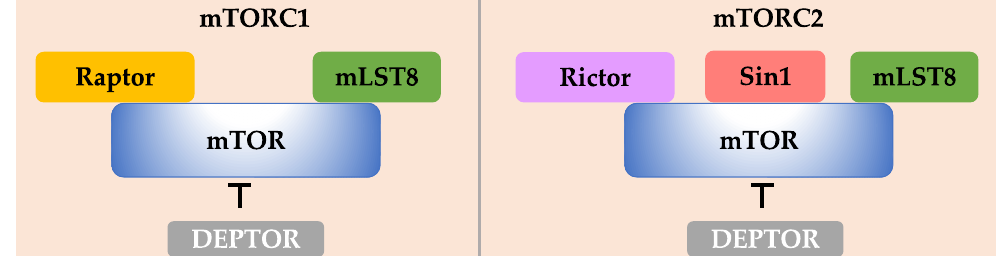
Figure 1. Core components of mTORC1 and mTORC2 complexes. mTOR and mLST8 are two shared subunits. Raptor defines the mTORC1 complex, while Rictor and Sin1 define mTORC2. DEPTOR is an endogenous inhibitor of both mTORC1 and mTORC2 complexes.